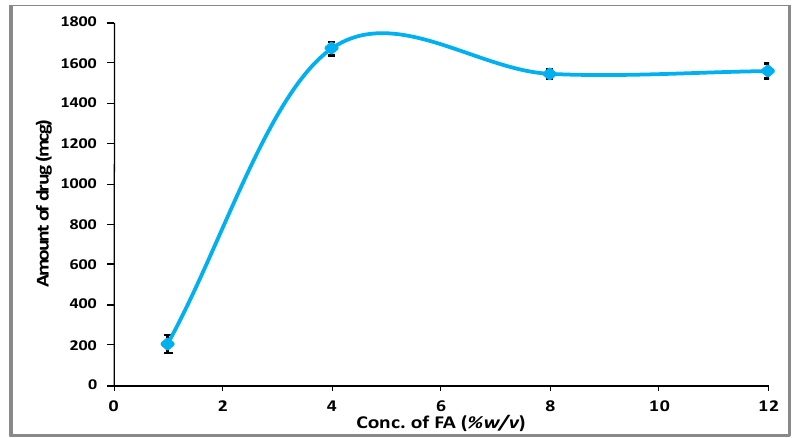
Figure 1. Phase solubility diagram of FA and CBZ at room temperature (25 ± 2 °C).